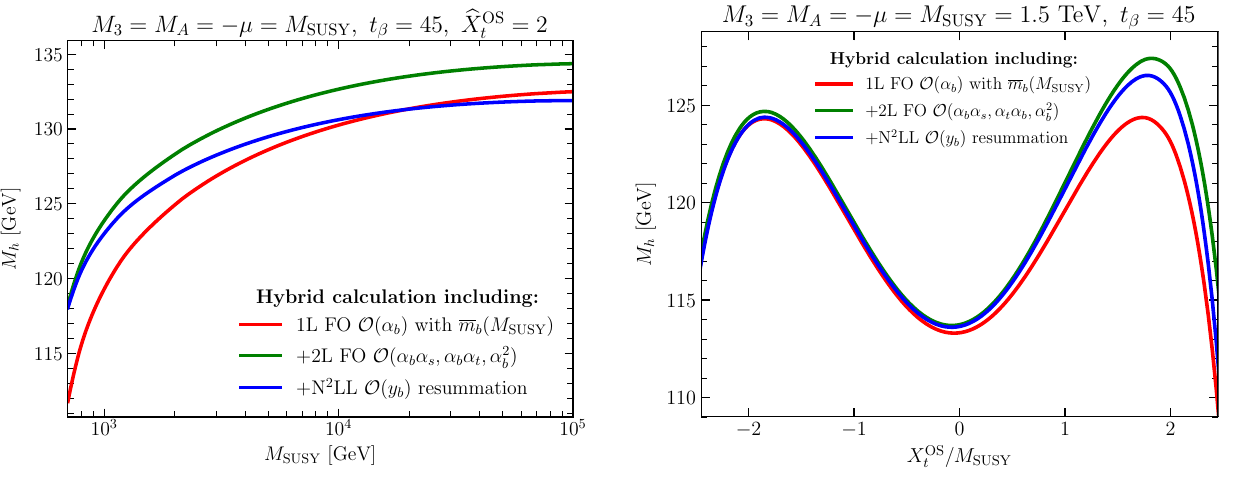
Fig. 3 Same as Fig. 2 but X t is renormalised in the OS scheme values of M SUSY . The difference between the two amounts to only ∼ 0 . 3 GeV for M SUSY = 700 GeV. In this